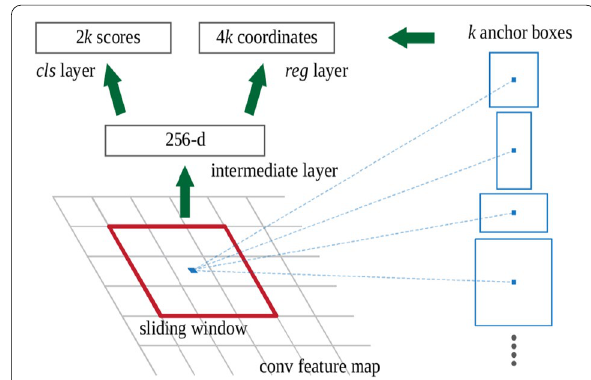
Fig. 2 An overview of the region proposal network (from Ren et